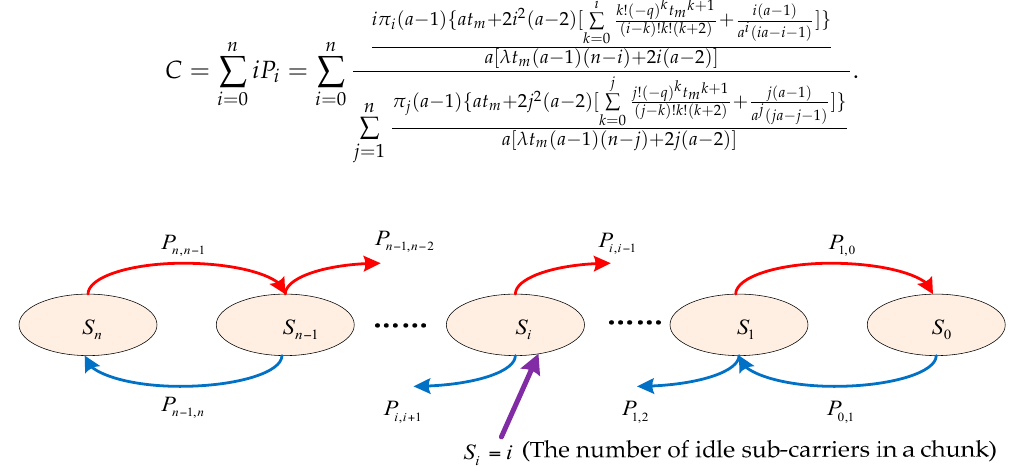
Figure 2. The state transition model for the number of idle sub-carriers in a chunk.